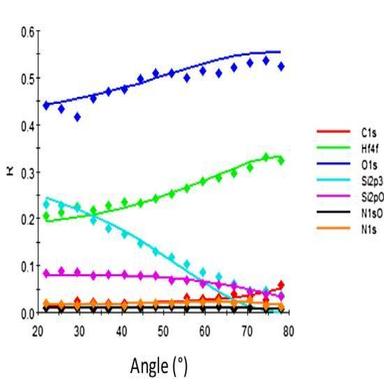
a. Normalized a.u. % ages as a function of angle for HfO2 /Chem-Ox IL (5A) after DPN; Fig. 4c. Depth profile result of Max Ent simulation of the data in Fig. 4a; Fig. 4b and d, as 4a and 4c, but for an equivalent wafer after PNA at 700C.